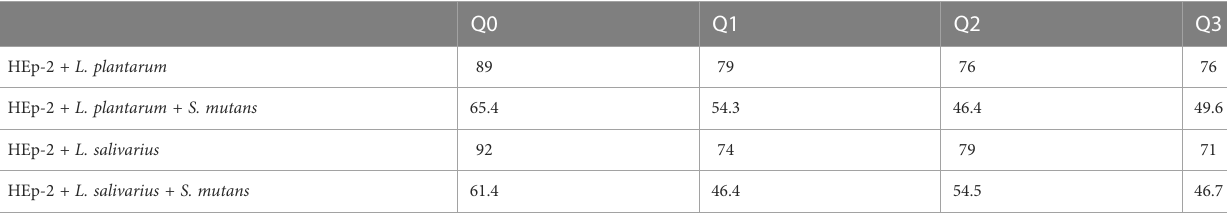
TABLE 1 The percent of live HEp-2 cells in the microscopic assay. HEp-2 + L. plantarum